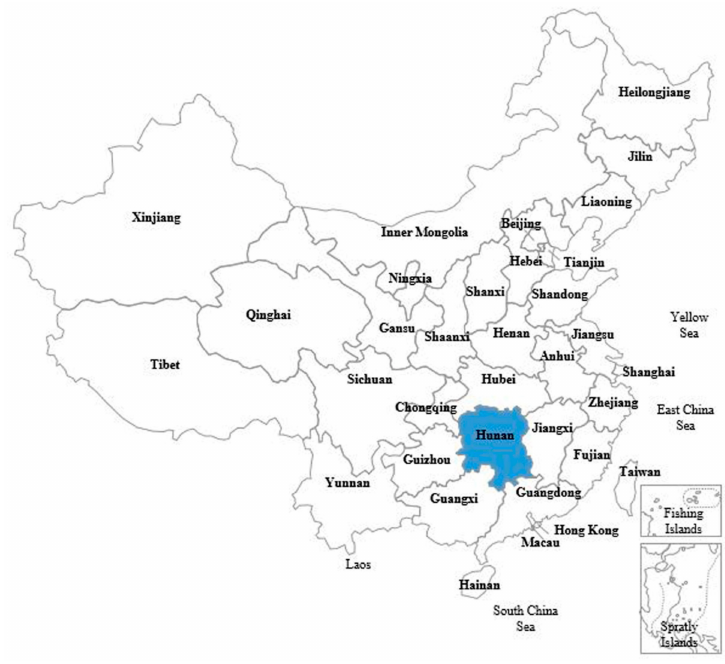
Figure 1. Geographical position of Hunan Province,